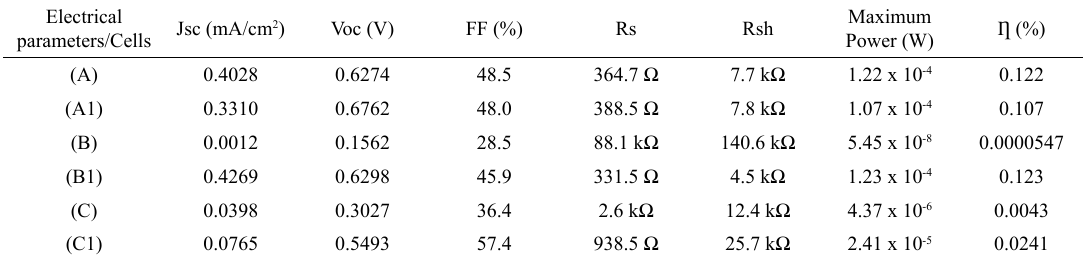
; (A1) TiO -450 °C; (B) NaTiNT; (B1) NaTiNT-450°C; (C) Nanoribbons and (C1) 2 2